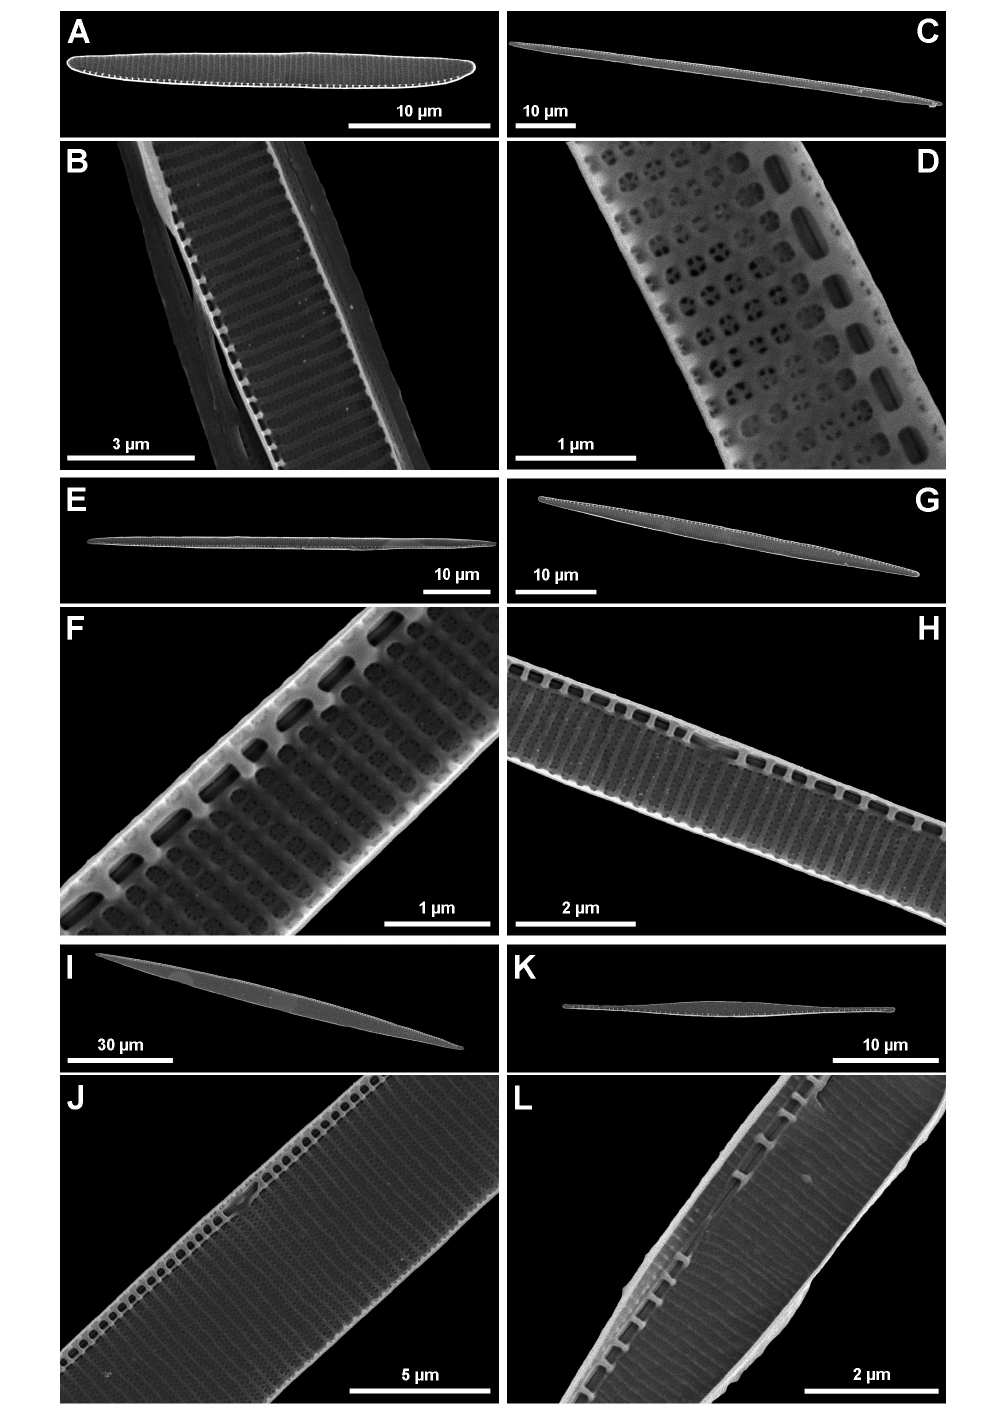
Fig . 2. – Scanning electron microscopy micrographs of Pseudo-nitzschia species. A and B, P. brasiliana ; C and D, P. caciantha ; E and F, P. calliantha ; G and H, P. delicatissima complex; I and J, P. fraudulenta ; K and L, P. galaxiae